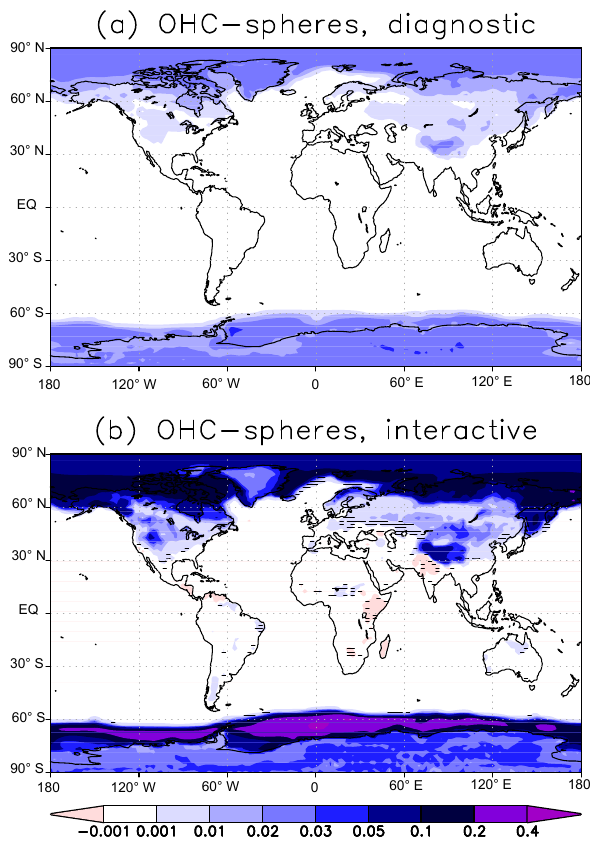
Figure 5. (a) Difference in annual-mean surface albedo between the OHC and spherical snow grain shape assumptions, based on diag- nostic radiation calculations in the SPH experiment. (b) The actual surface albedo difference between the NONSPH and SPH experi- ments, in which the OHC and spherical shape assumptions influ- ence the climate simulation interactively. The albedos are weighted by the incoming solar flux at the surface. Hatching indicates differ- ences that exceed the threshold for colour shading (0.001) but are not significant at the 5% level.